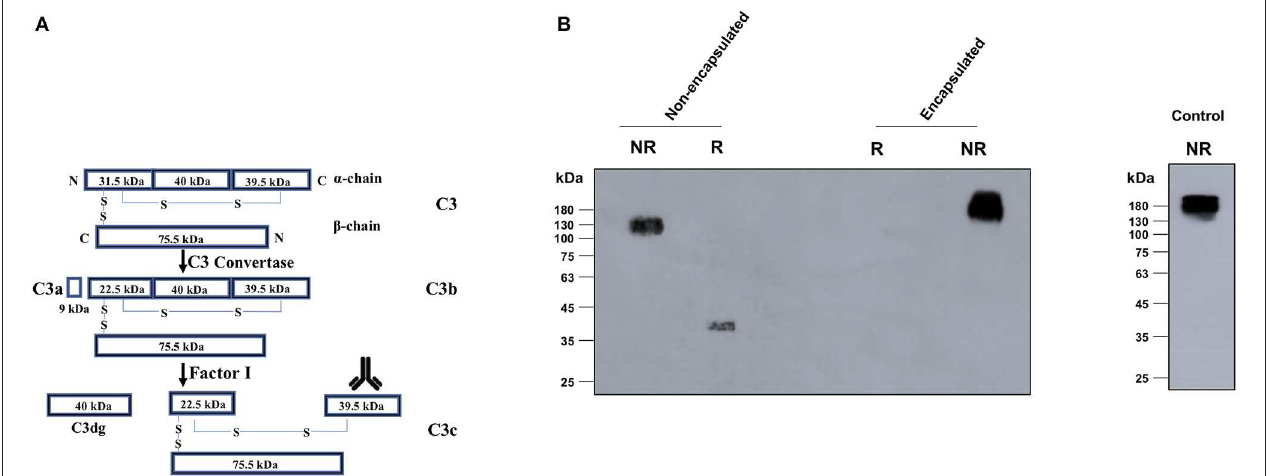
FIGURE 3 | Detection of the C3c processed fragment with encapsulated and non-encapsulated strains of Bacillus anthracis . (A) Schematic representation of the C3 processing during complement fixation depicting the cleavage of C3 into C3b, C3c, and C3d. C3b remains surface bound, whereas C3c is released in the fluid-phase media. (B) Non-encapsulated and encapsulated strains of B. anthracis were incubated in 10% normal human serum and C3c (138 kDa) detected in the supernatants by immunoblot assays using specific antibodies against the 40-kDa C-terminal fragment of alpha chain of C3c (marked by the antibody image in A ). C3c formation was only observed with the non-encapsulated Sterne strain. The 140-kDa C3c (alpha and beta chains) protein and 40-kDa C3c (alpha chain C-terminus) were detected under non-reducing and reducing conditions, respectively, with the non-encapsulated B. anthracis Sterne strain. The unprocessed 189-kDa C3 protein from human serum was detected in the supernatants of the encapsulated virulent strain consistent with the same detected in the 1% normal human serum (positive control). R, reducing; NR,